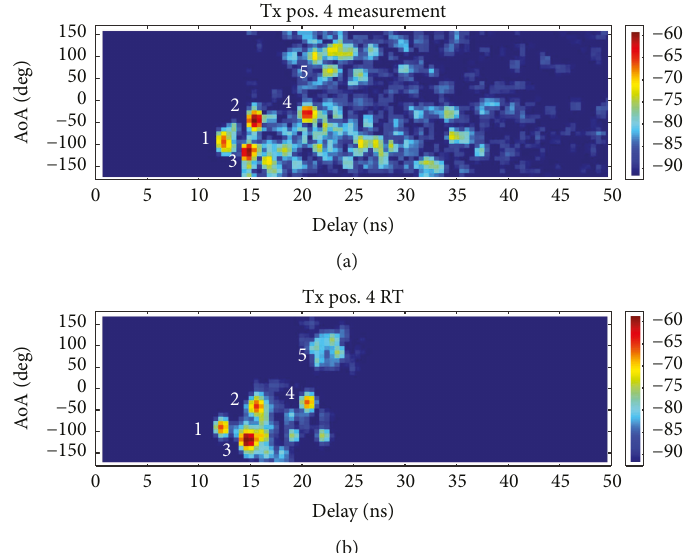
Figure 18: Measured (a) and RT-simulated (b) power-angle-delay pro fi les for Tx position 4 with the metallic plate obstructing the LOS in the small o ffi ce